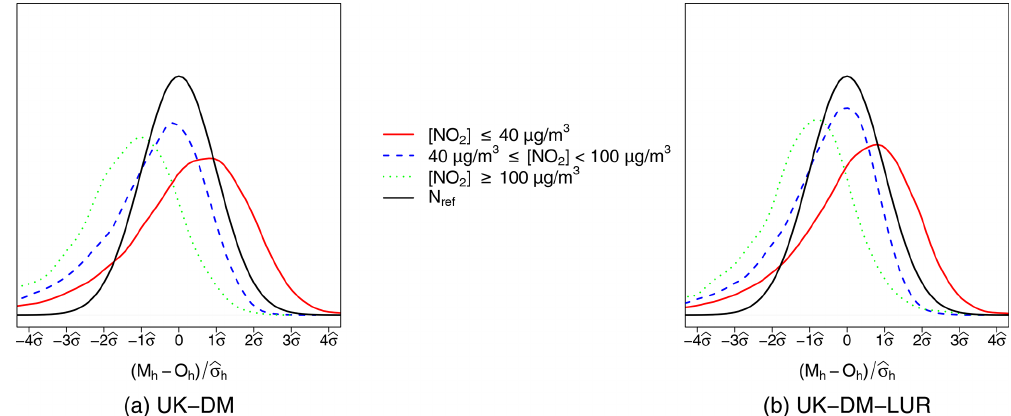
Figure 9. PDFs by observed NO 2 ranges of the hourly bias, normalized by the standard deviation error, for all monitoring stations in LOOCV during 2019 for (a) UK-DM and (b) UK-DM-LUR